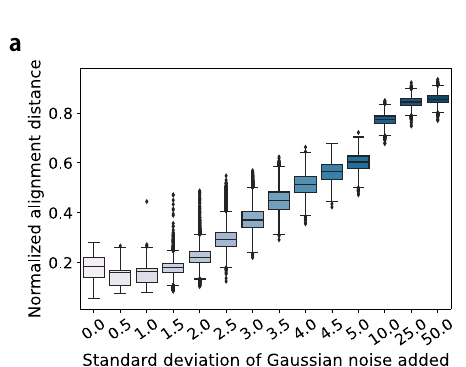
Fig. 3 | A performance indicator of CAPITAL as a function of the noise level on the synthetic datasets. The horizontal axis indicates the standard deviation of Gaussian noise that was independently added 100 times to each of the expression counts obtainedby splitting a single-cellcount matrix inthe 68 synthetic datasets, which results in 95,200 pairs of trajectories. a Performance evaluation in cluster – cluster alignment. b Performance evaluation in cell – cell alignment. 10